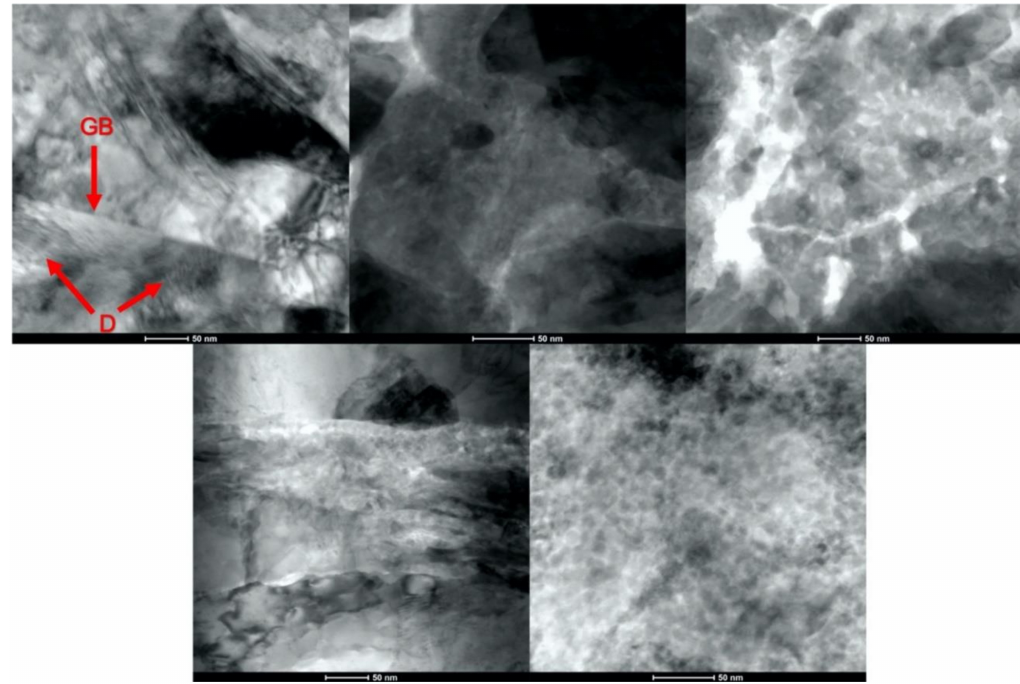
Figure 21. STEM micrographs of the deformed microstructure of the nanostructured cold sprayed coatings in the cross-sectional orientation. Note that the scale bar represents 50 nm. Dislocation accumulation (D) at a prior grain boundary (GB) is similar to observations made in [83].